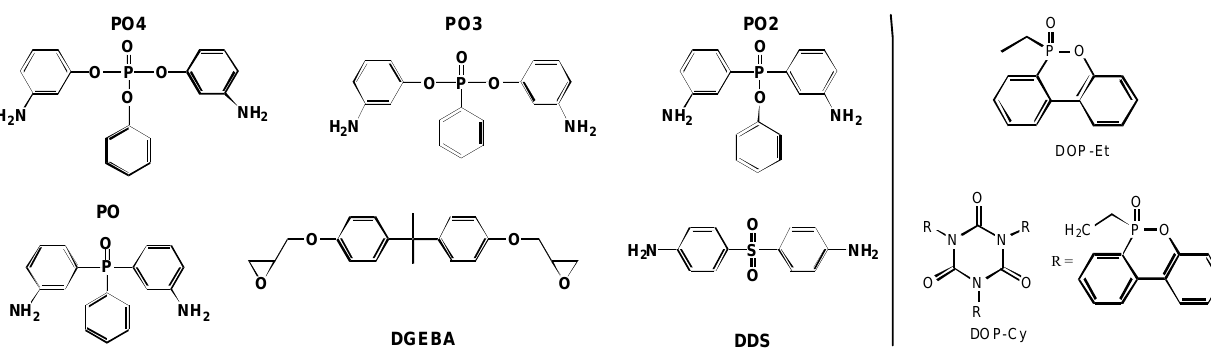
Figure 4. Chemical structures of epoxy and hardeners used (left) and added 9,10-dihydro- 9-oxy-10-phosphaphenanthrene-10-oxide (DOPO)-based flame retardants